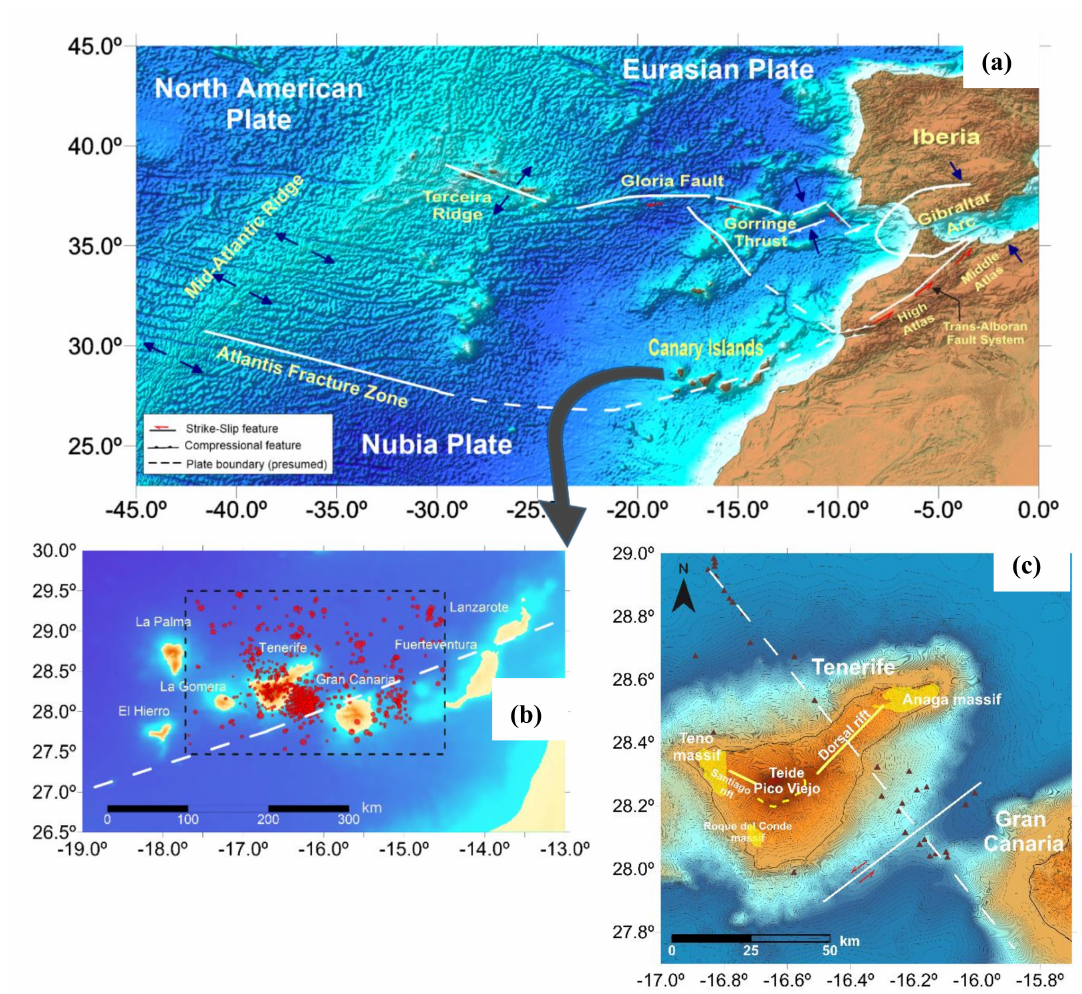
Figure 1. ( a ) Digital elevation map of the central Atlantic area near the Canary Islands based on the GEBCO (General Bathymetric Chart of the Oceans) dataset (https: // www.gebco.net). The main tectonic features and regimes are indicated along the plate boundaries. ( b ) Map showing the seven major islands of the Canary Archipelago and the epicentres of the earthquakes (mbLG > 1.2) recorded in the dashed rectangular area during 2011–2017. The white dashed line that crosses the archipelago marks the presumed southern boundary of the Morocco microplate, as proposed by [24]. ( c ) Some geological features of Tenerife: rifts (solid yellow lines); massifs (yellow areas); the Teide-Pico Viejo volcanic complex; the Las Cañadas caldera wall (dashed yellow line); the volcano-tectonic direction (dashed white line), which is an inferred submarine alignment based on the volcanic seamount distribution (brown triangles) and a slope break in the SW flank of Gran Canaria proposed by [25]; and the sinistral strike-slip fault (solid white line) located between Tenerife and Gran